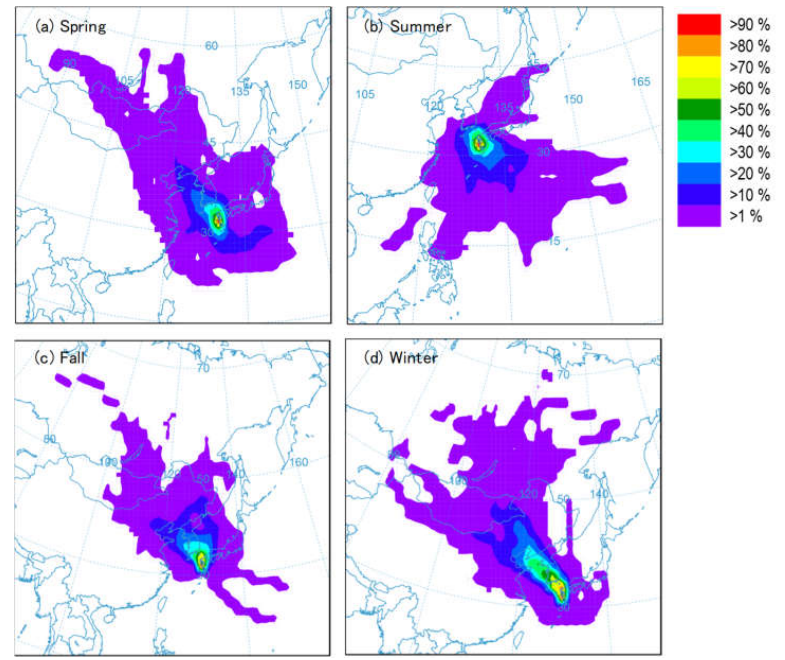
Figure 2. Frequency with which the back trajectories from the sampling site passed over a grid cell calculated by HYSPLIT Model of the National Oceanic and Atmospheric Administration, USA: ( a ) 29